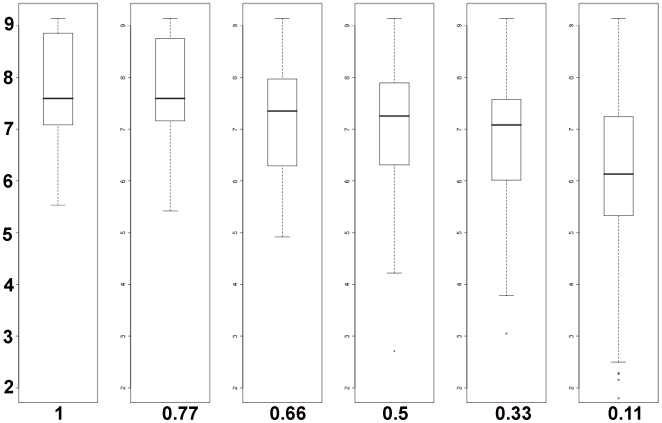
Correlation between octamer motifs and peak score values.Boxplot, showing the distribution of the quality of octamer motifs in relation to our defined peak score. For a peak-score of 0.5, half of the motifs will have a motif-score of 7.3 and above. The average motif score will decrease slightly for a peak score of 0.33 and a significant drop in the motif score can be perceived for a peak score of 0.11.